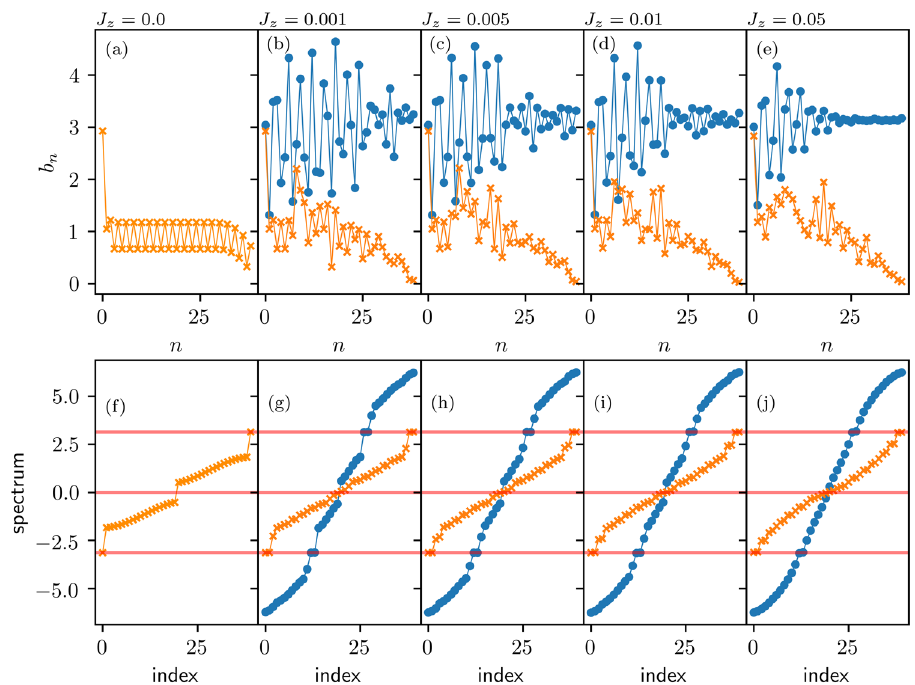
Fig. 5 Interaction dependence of the parameters of the Krylov chain. The Krylov chain hopping parameters b n (panels a – e ) and the corresponding spectra (panels f – j ), where n labels the sites of the Krylov chain. The results are for a magnetic fi eld of strength g = 0.3, period T = 8.25, and for the interaction J z increasing from panels a – e and panels f – j , with the J z = 0 case shown in panels a , f . The system size for J z = 0 is L = 20 (same as Fig. 4), while that for the interacting cases is L = 12. Blue circles are for the unfolded spectra, while orange crosses for non-zero J z are for a gauge choice where the spectra have been folded back into the Floquet Brillouin zone (FBZ). The folded spectra (orange crosses ( g – j )), and the corresponding b n (orange crosses ( b – e )) bear a closer resemblance to the free problem ( a , f ). The horizontal red lines in panels f – j indicate energies at 0, ± π